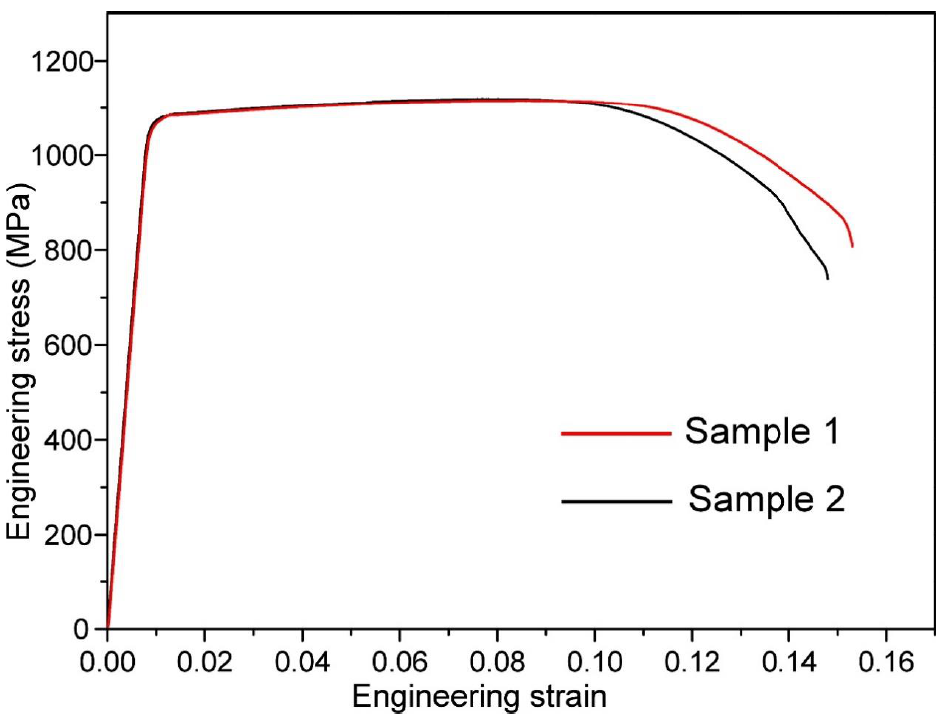
Figure 5. Engineering stress – strain curves of the Ti55511 alloy. Materials 2022 , 15 , x FOR PEER REVIEW